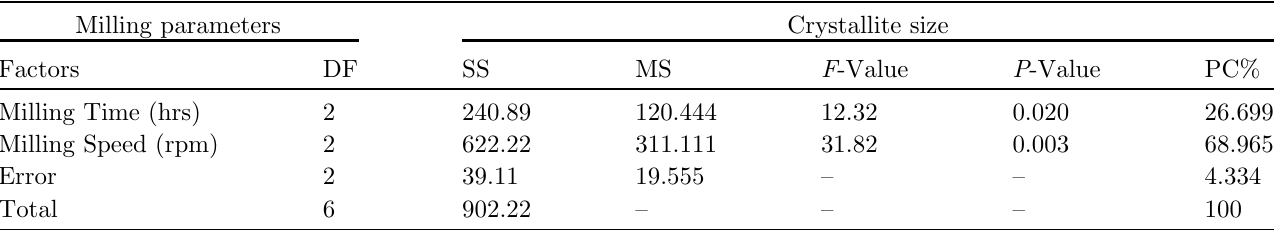
Table 5. ANOVA analysis for crystallite size.